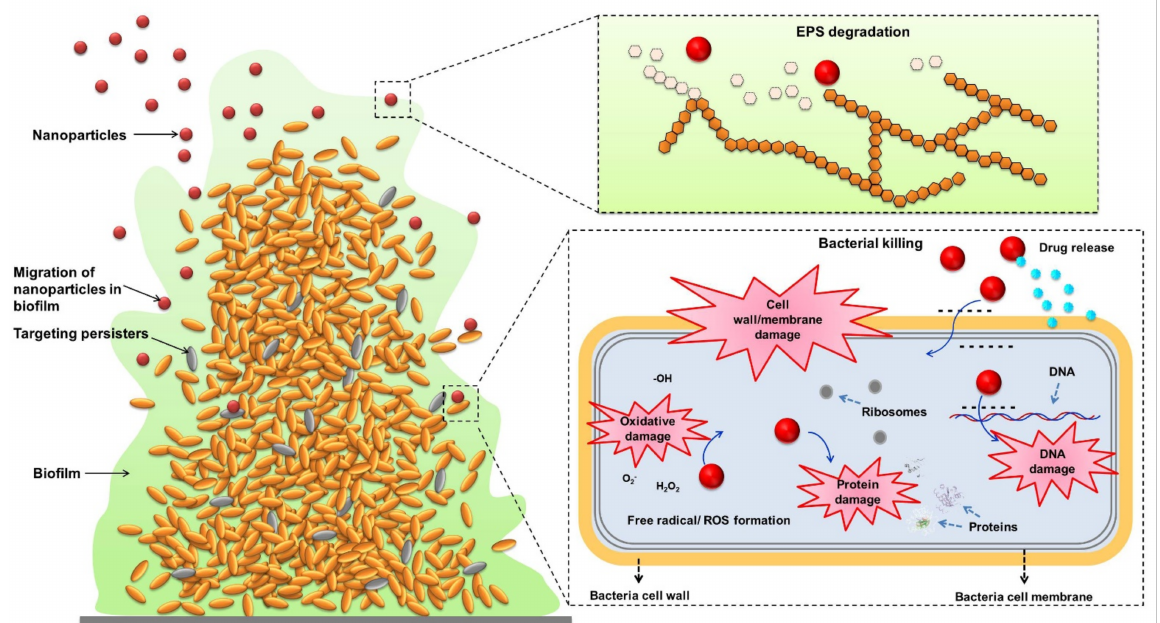
Figure 3. The mechanisms antibiofilm nanoparticles use for eradicating pathogenic